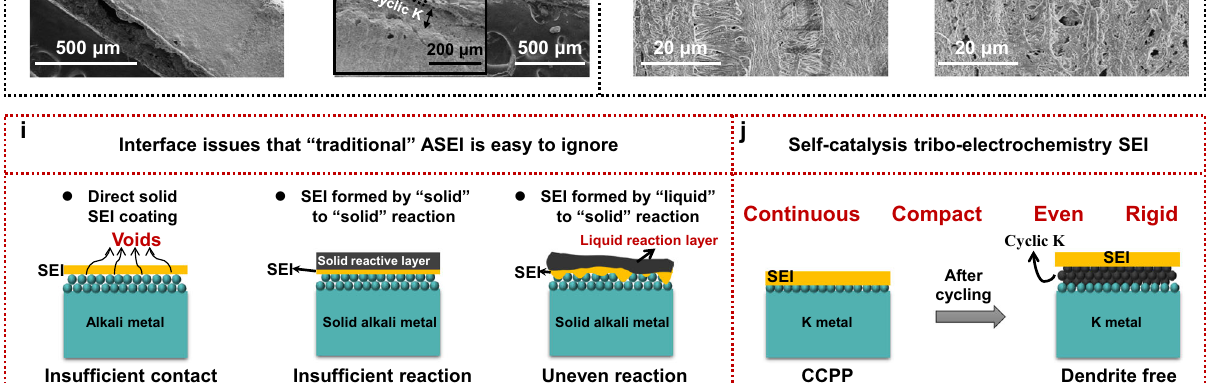
(cid:2) Direct solid SEI coating